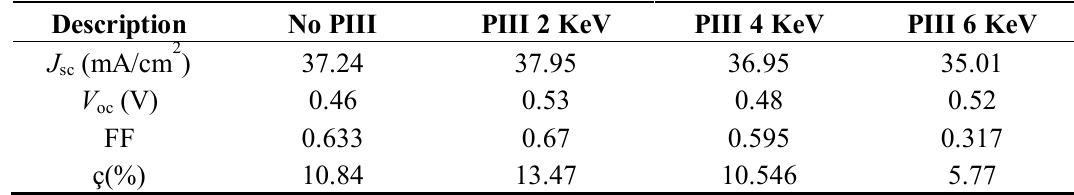
Table 2. The summary table of without PIII, PIII 2 KeV, PIII 4 KeV, and PIII 6 KeV homojunction solar cells with AlO x